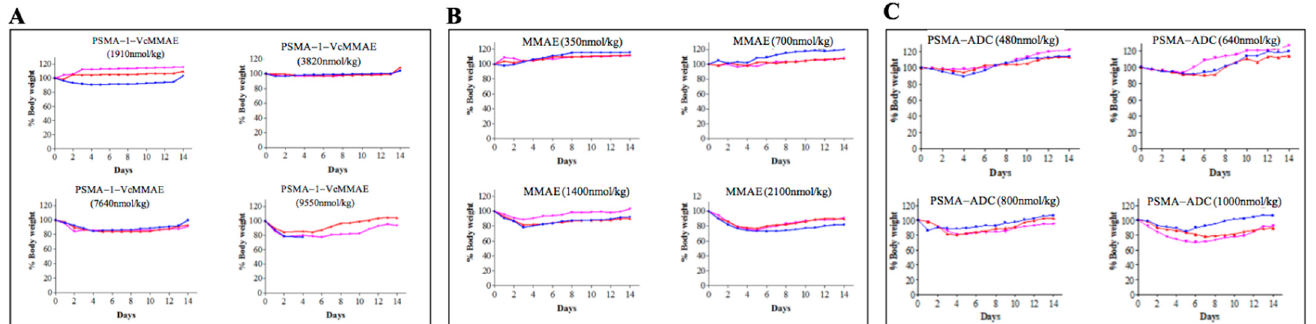
Figure 7. Determination of maximum tolerated dose (MTD) of drugs. Tumor free male nude mice received a single dose of PSMA-1-VcMMAE ( A ), MMAE ( B ), and PSMA-ADC ( C ). Loss of 20% of body weight was used as the criteria to determine MTD. Each dose group had three mice as indicated in red, blue, and pink colors.